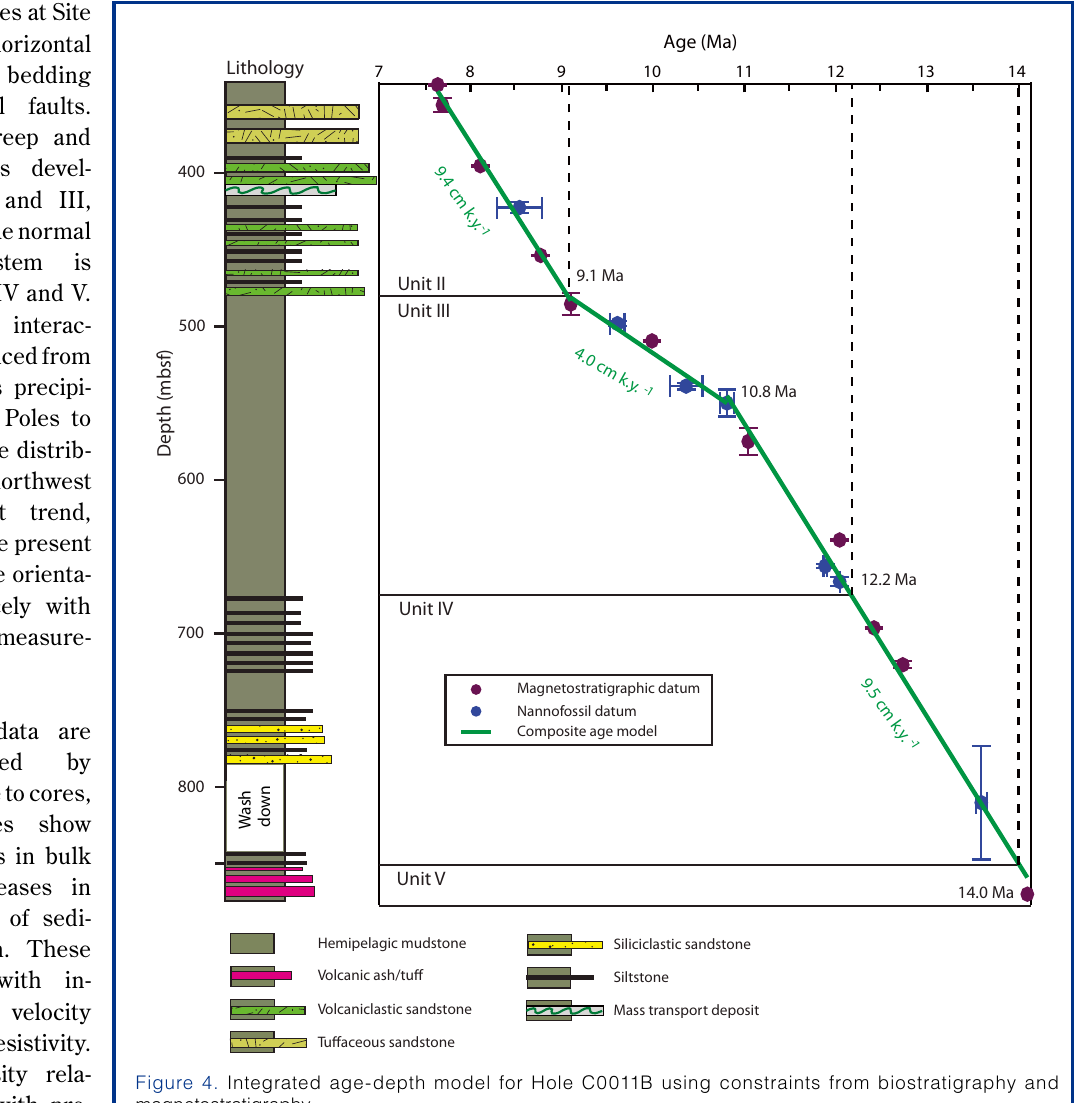
Figure 4. Integrated age-depth model for Hole C0011B using constraints from biostratigraphy and magnetostratigraphy.